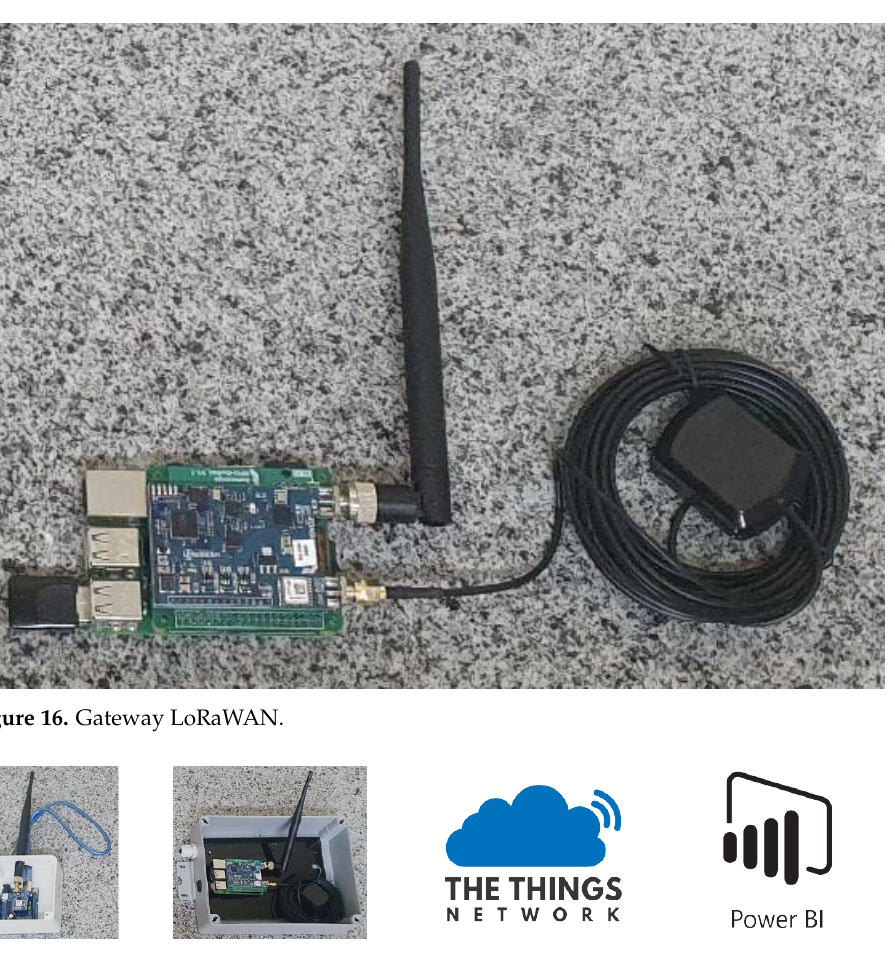
Figure 17. LoRaWAN Architecture proposed and implemented in this work.